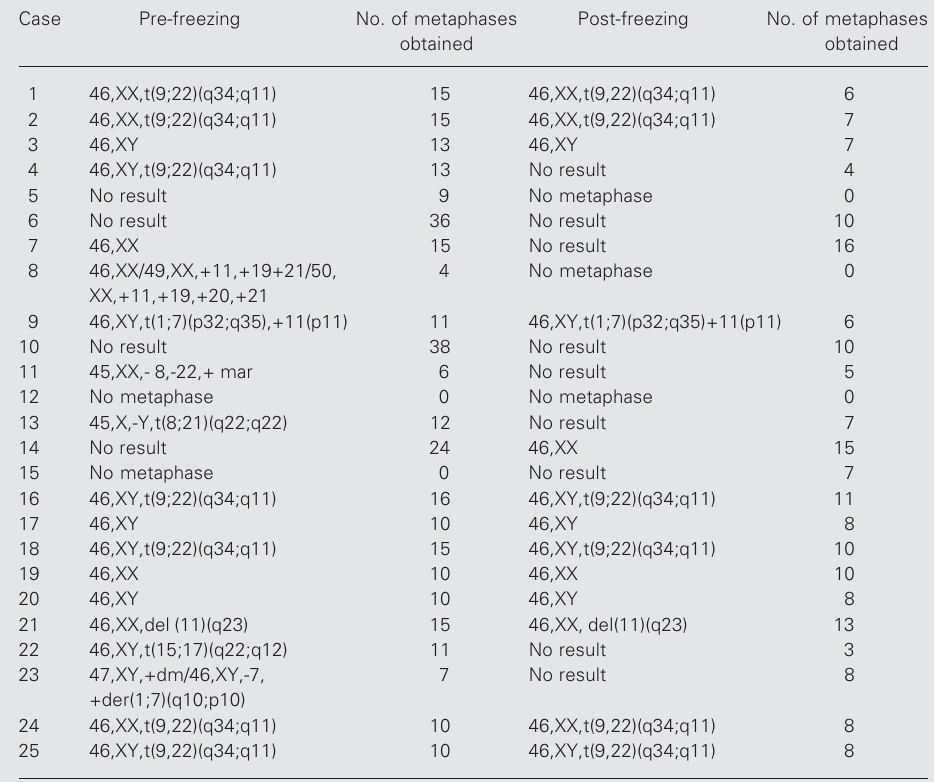
Table 2. Pre- and post-freezing